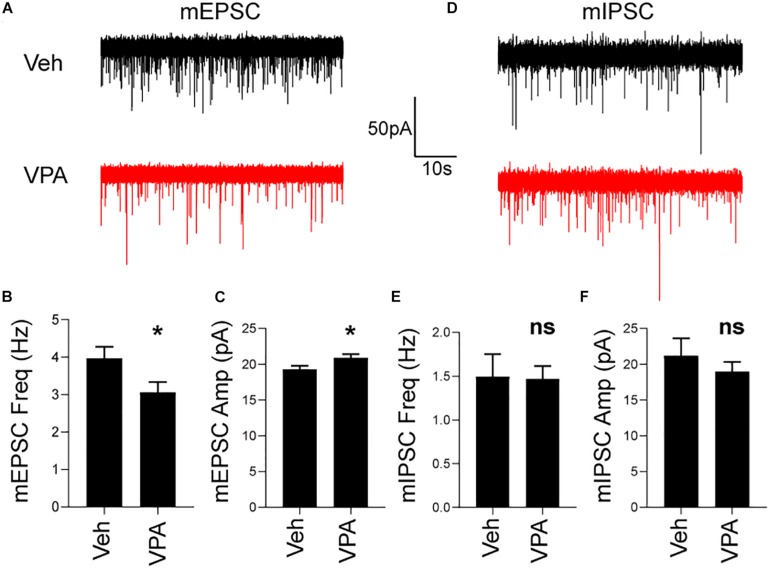
In utero VPA exposure impairs striatal excitatory synaptic transmission at P28. (A) Representative voltage-clamp recordings of mEPSCs from SPNs in Veh or VPA treated mice. (B) Reduction in mEPSC frequency in VPA-treated mice. Veh: N = 19 cells, VPA: N = 21 cells. t38 = 2.246, p = 0.0306. (C) Increased in mEPSC amplitude in VPA-treated mice. Veh: N = 19 cells, VPA: N = 21 cells. t38 = 2.113, p = 0.0412. (D) Representative voltage-clamp recordings of mIPSCs from SPNs in Veh or VPA-treated mice. No difference in mIPSC (E) frequency or (F) amplitude. Veh: N = 10 cells, VPA: N = 19 cells. *p < 0.05, ns not significant.